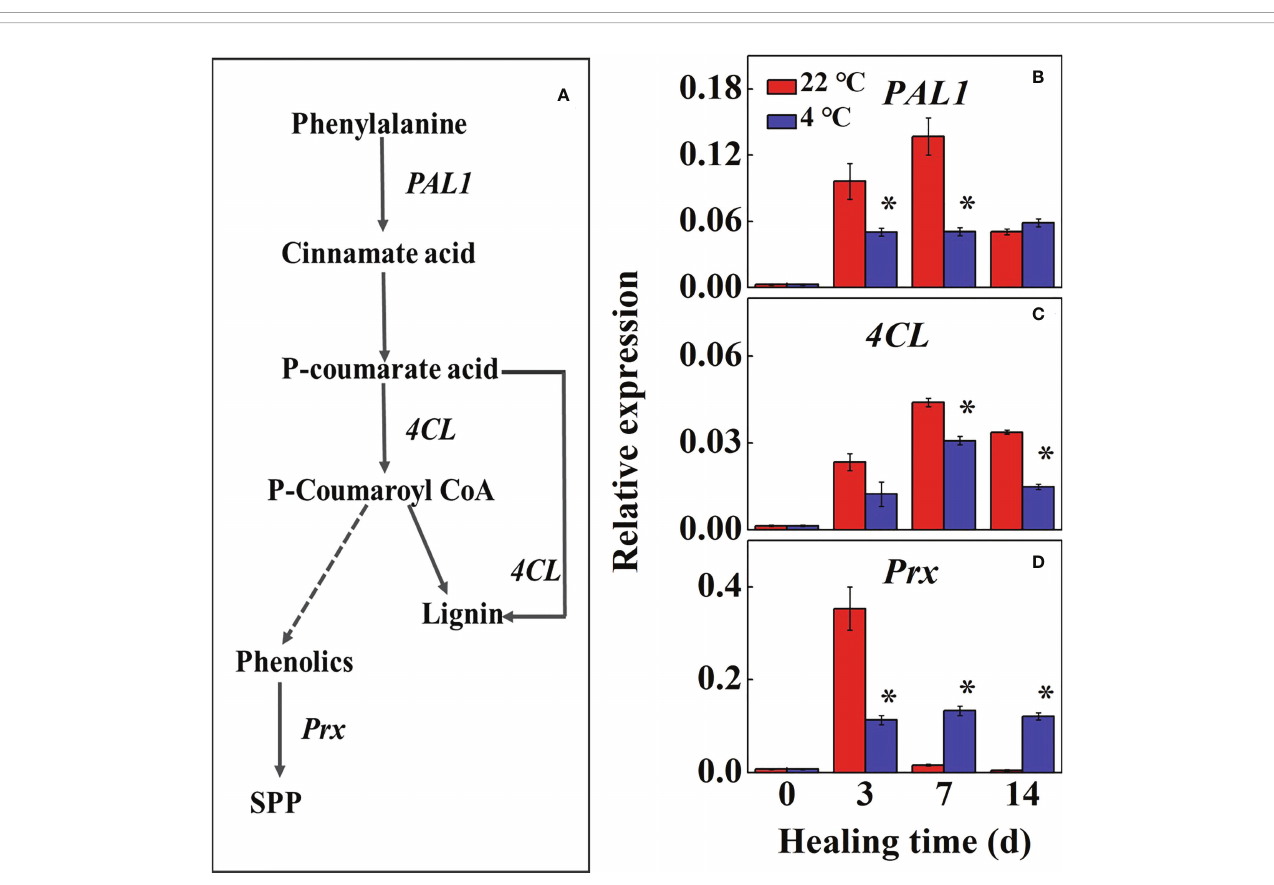
FIGURE 4 (A) The pathway of phenylpropane metabolic and effects of different temperatures on the expression of (B) Phenylalanine ammonia-lyase (PAL1), (C) 4- coumarate-CoA (4CL) and (D) anionic peroxidase (Prx) at the wound sites of potato tubers during healing. The symbol (*) indicates signi fi cant differences among different treatments at p < 0.05.